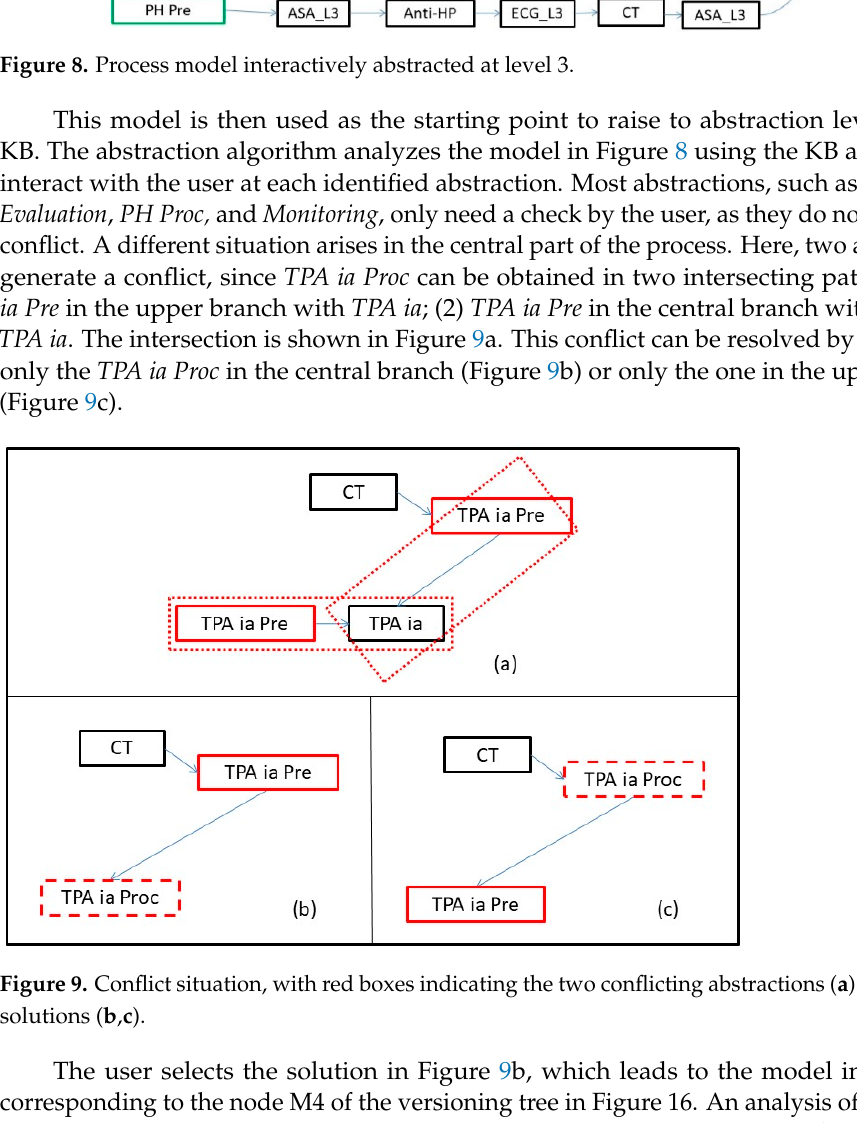
Figure 8. Process model interactively abstracted at level 3.